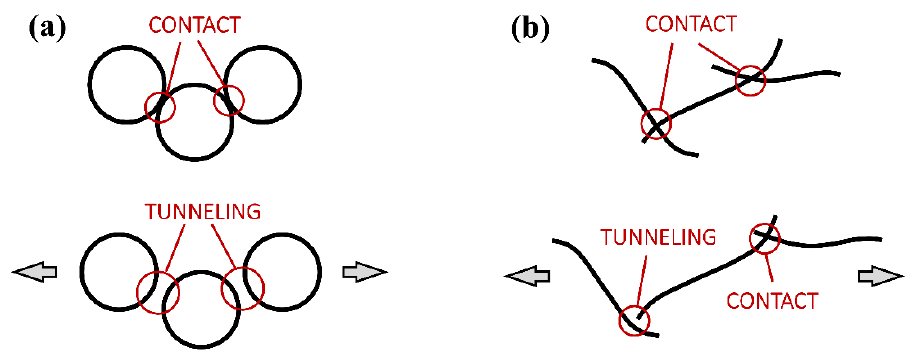
Figure 6. Mechanism for the piezoresistivity of ( a ) CB and ( b ) CNT systems. As presented in Error! Reference source not found. , the laminates containing two SMPs showed the self-monitoring behavior of both sensing laminae at the same time. As expected, the internal lamina, closer to neutral axis, experienced less deformation and, thus, lower electrical resistance variation. This is particularly evident in the CB-loaded samples ( Error! Reference source not found. a), which presented high GF, while the small GF associated with CNT systems caused a lower variation of electrical resistance between the two self-monitoring plies within the same sample ( Error! Reference source not found. b).